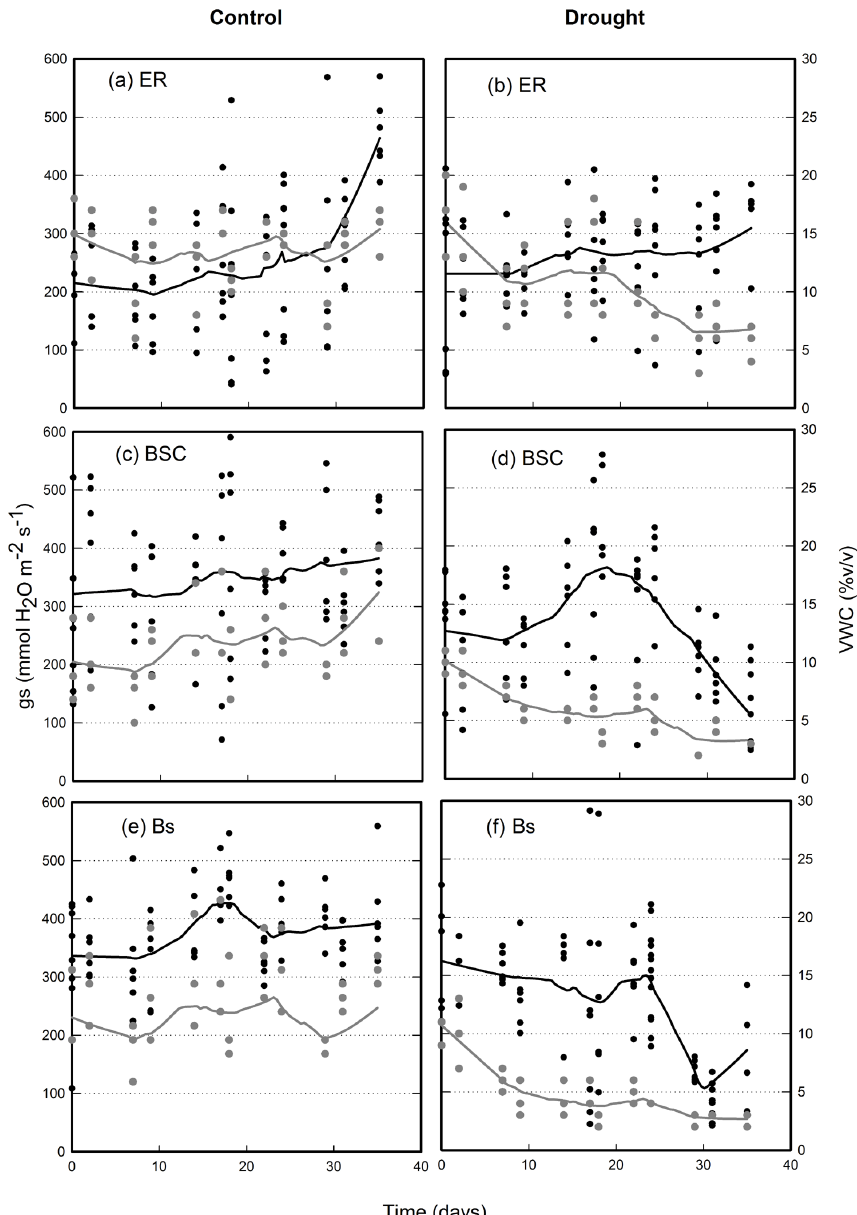
Figure 2. Volumetric water content of soil (VWC, in gray) and stomatal conductance of Nothofagus pumilio seedlings (gs, in black) grown in different treatments of soil cover and under conditions of full and restricted watering (control and drought, respectively). Crosses are mean values for each measured date and lines are locally weighted polynomial regressions (LOESS) performed on all values for each date. ER, soil covered by Empetrum rubrum ; BSC, soil covered by biological soil crust; and Bs, bare